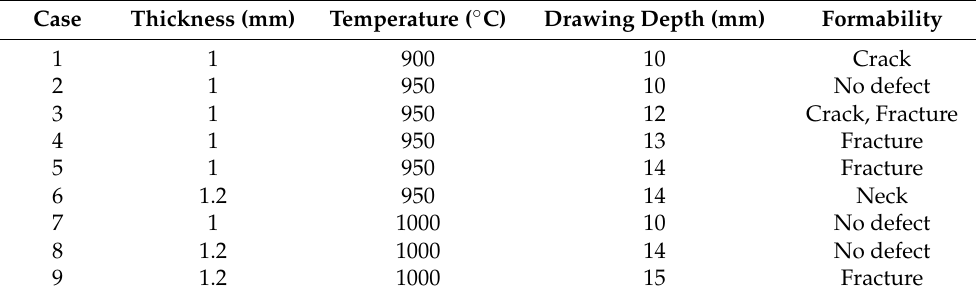
Table 2. Hot stamping test results of T-type parts according to thickness and temperature of sheet